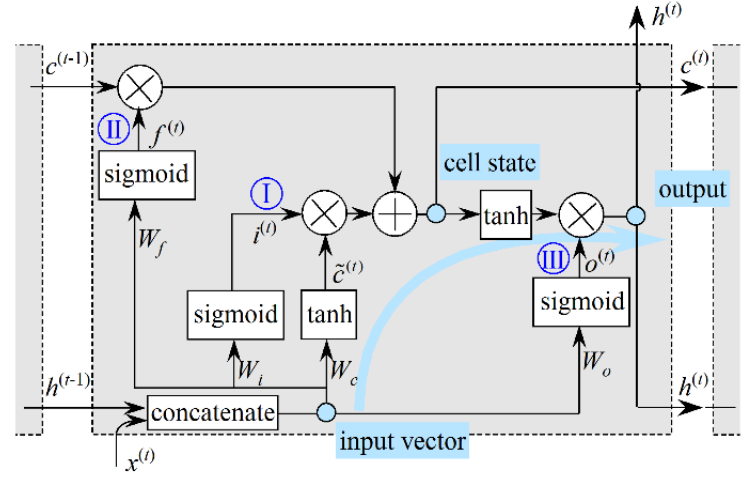
Figure 9. LSTM schematic. I, input gate; II, forget gate; III, output